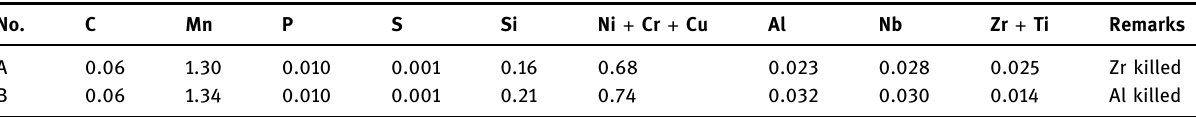
Table 1: Chemical composition of steels A and B